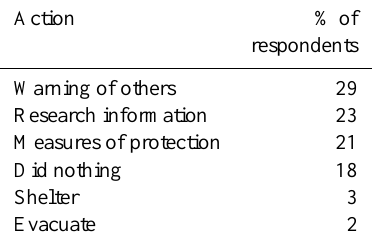
Table 2. Actions taken after hearing the alert siren. Action % of